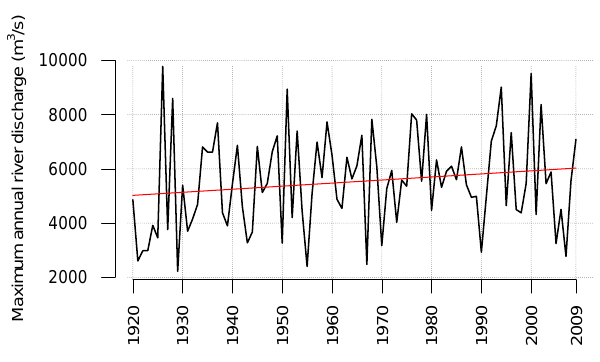
Fig. 5. Annual maxima of the Po River at Pontelagoscuro daily dis- charge series (1920–2009) and linear regression line.